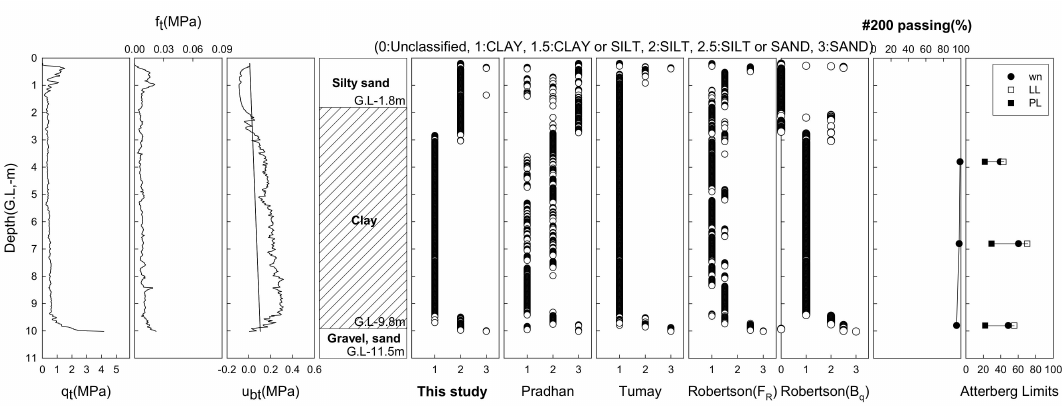
Figure 13. Verification results at Jeonnam Dojang new port site.